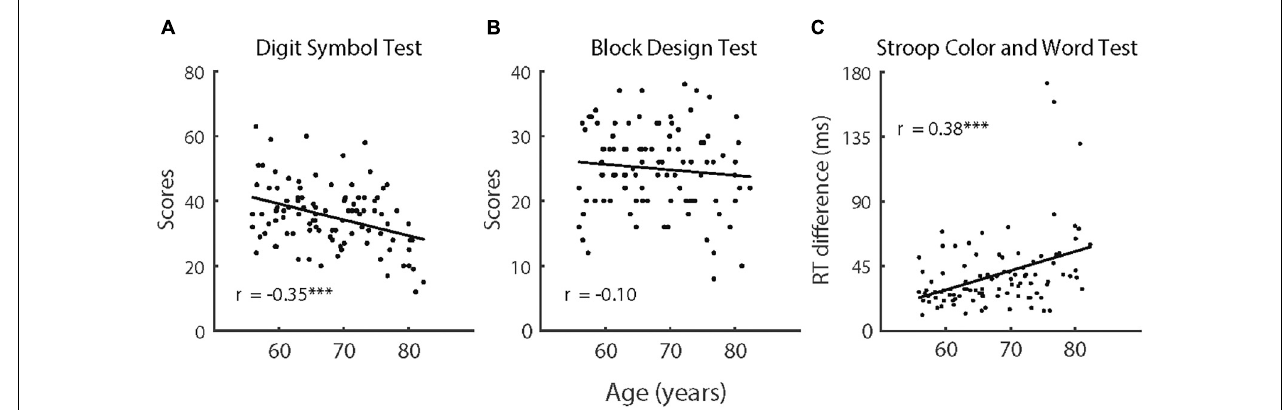
FIGURE 6 | (A) The scores in Digit Symbol Test, (B) the scores in Block Design Test, and (C) the reaction time difference in Stroop Color and Word Test as a function of age of older participants ( n = 100). The solid lines indicate linear regression model fits and rs represent the Pearson correlations between variables. Note, ∗∗∗ p <